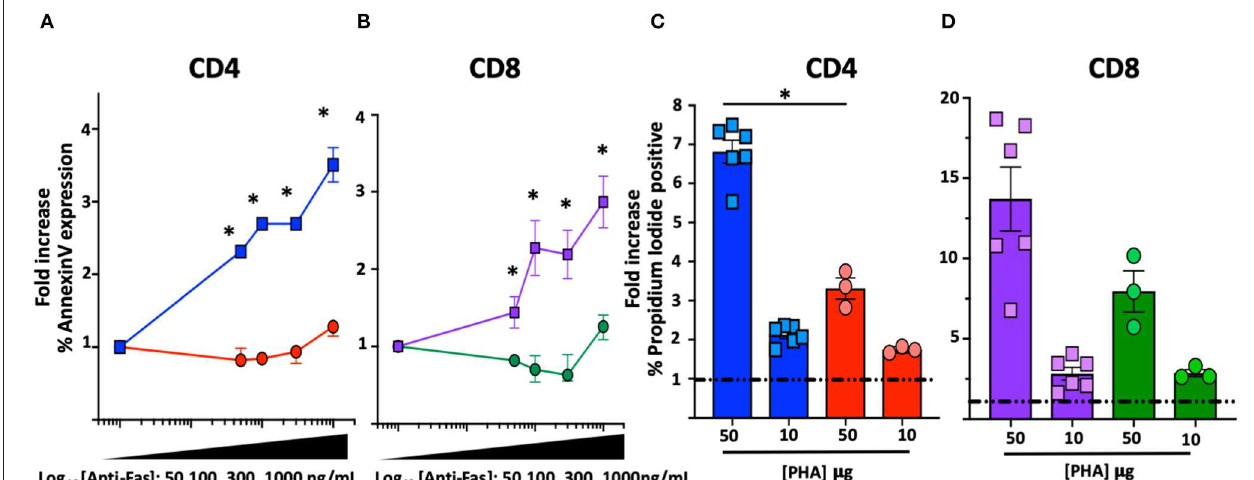
FIGURE 2 | FAS-induced apoptosis and activation-induced-cell death (AICD) in T cell blasts from the index patient and healthy subjects. *Comparisons with statistically significant differences. (A) Average fold increase ± SEM of Annexin-V expression in CD4T cell blasts from index patient (red) and 2 different healthy controls (blue) with different concentrations of anti-FAS crosslinking antibody. (B) Average fold increase ± SEM of Annexin-V expression in CD8T cell blasts from index patient (green) and 2 different healthy controls (purple) with different concentrations of anti-FAS crosslinking antibody. (C) Average fold increase ± SEM in Propidium Iodide (PI) positive CD4T cell blasts from index patient (red) and 2 different healthy controls (blue) with 2 different concentrations of PHA. (D) Average fold increase ± SEM in PI positive CD8T cells blasts from index patient (green) and 2 different healthy controls (purple) with 2 different concentrations of